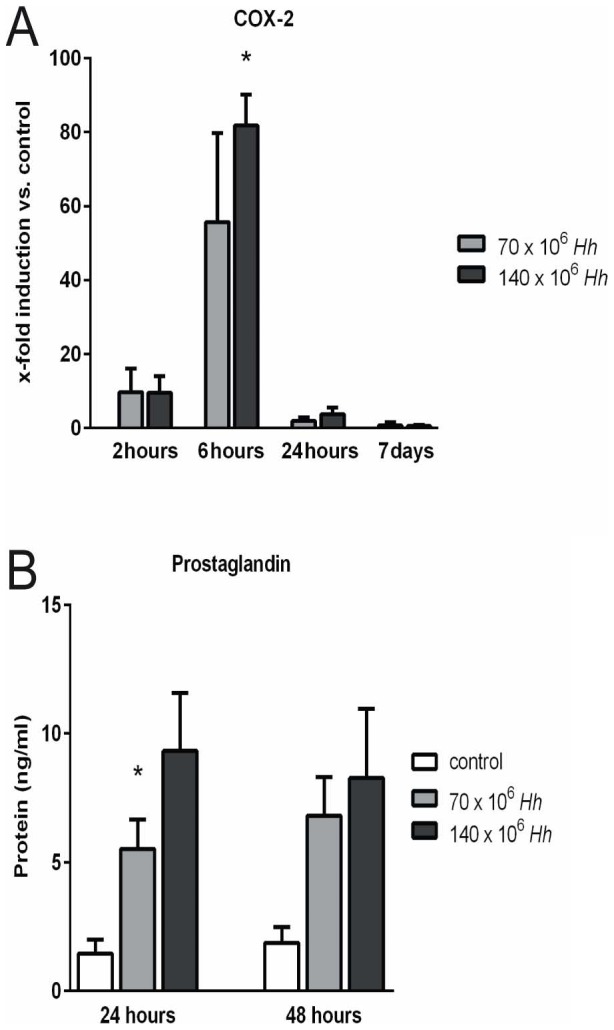

H. hepaticus ATCC 51449 induces an early transient COX-2 expression, resulting in an increased PGE2-synthesis by primary human hepatocytes (PHH).PHH were co-cultured with H. hepaticus at a MOI of 50 (70×106 Hh) or 100 (140×106 Hh) bacteria per hepatocyte (n = 3). (A) Real-time RT PCR of hepatocytes revealed significantly increased mRNA expression of COX-2 6 hours after infection. COX-2 mRNA is expressed as the fold induction compared to untreated control culture from the same hepatocyte donor for each time point. (B) Induction of COX-2 led to an increased synthesis of PGE2 by PHH as measured in the supernatant of co-cultured hepatocytes by ELISA with maximum concentration at 24 hours after infection with H. hepaticus at a MOI of 100 cells per hepatocyte (n = 3). * = p<0.05 versus control.